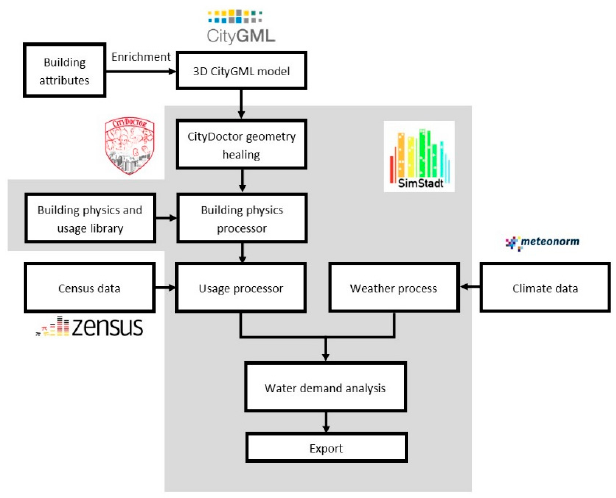
Figure 1. Water analysis workflow in a SimStadt simulation environment with dataset sources. The blocks lying in gray background are included in SimStadt Water Demand